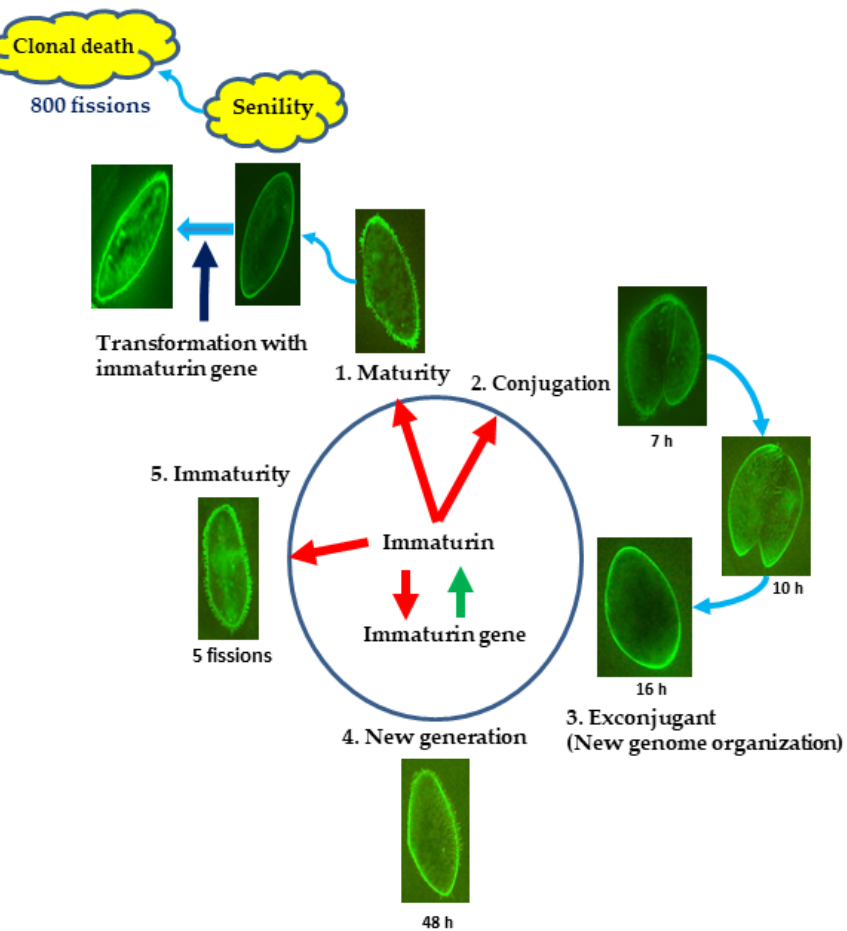
Figure 8. Schematic diagram of the action of immaturin gene and immaturin polypeptide. Photographs in the schematic diagram show fluorescence images of immaturin at each stage of the life cycle. The formation of a new generation begins with the mating reaction of mature cells. In the mating reaction, two cells adhere to form a fertilization nucleus with their own germ nuclei. The new generation begins in the immaturity stage, passes through the maturity stage, and shifts to the senile stage. Our investigation detected immaturin at all life cycle stages. In microinjection experiments, immaturin suppresses mating ability during the immaturity stage and promotes mating ability during senescence. The results of visualization experiments by immunofluorescence provide molecular clues for understanding the contradictions in the microinjection experiments. The red arrow indicates the direction of action of immaturin and the green arrow indicates the synthesis of immaturin polypeptides from the immaturin gene.